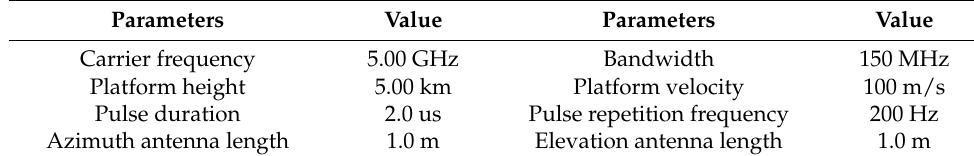
Figure 8. Simulated scene with topography occlusion to verify the effectiveness of the proposed beam occlusion judgment algorithm. Table 1. Basic SAR system parameters for experiments in Figure 9.